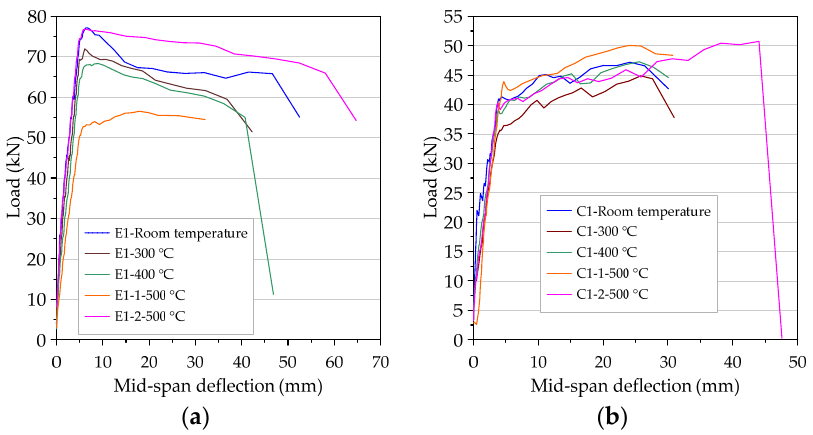
Figure 20. The load–deflection curve of the beam after being subjected to high temperatures: ( a ) the experimental group and ( b ) the control group.